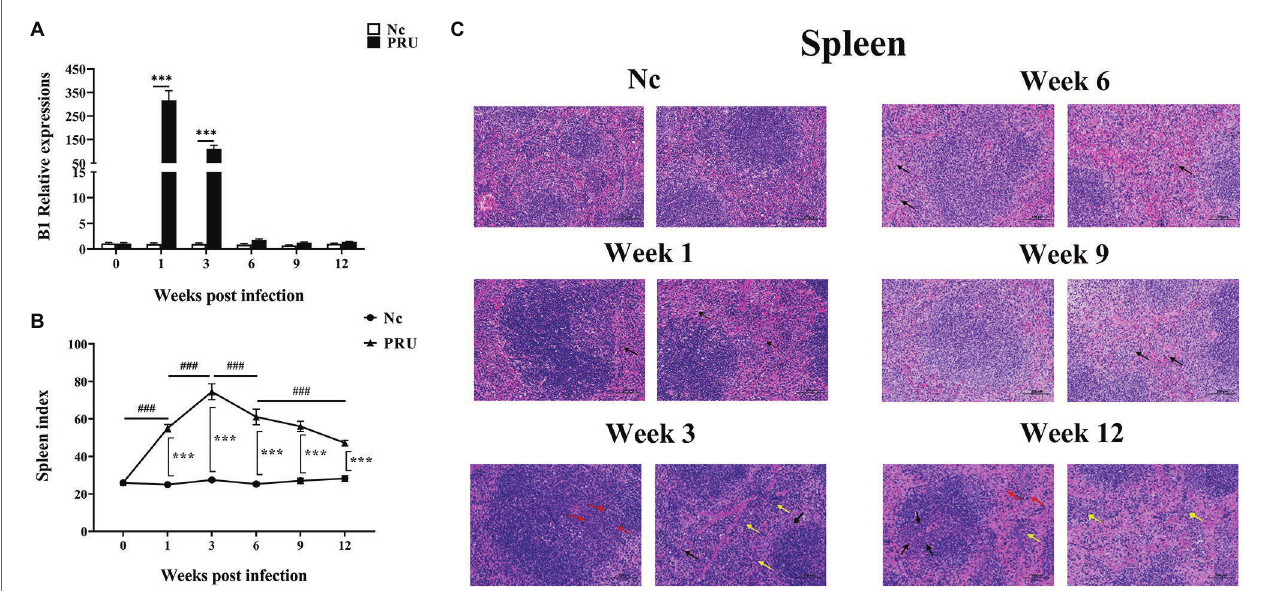
FIGURE 1 | Dynamic pathological changes in the spleen during chronic Toxoplasma gondii infection. (A) Relative expression of TgB1in the spleen at 0, 1, 3, 6, 9, and 12 weeks post infection in the spleen. (B) Spleen index values of the PRU and Nc groups. The results are representative of three independent experiments with five mice per group per experiment; with data denoting means ± SDs; (C) H&E staining of spleen sections at different time points post infection. *** ,### p < 0.001, *Indicates comparison with the control group. # Indicates comparison with other time points. The black arrow indicates neutrophil infiltration in the red pulp, the yellow arrow indicates extramedullary hematopoietic cell infiltration, and the red arrow indicates extramedullary hematopoietic cell